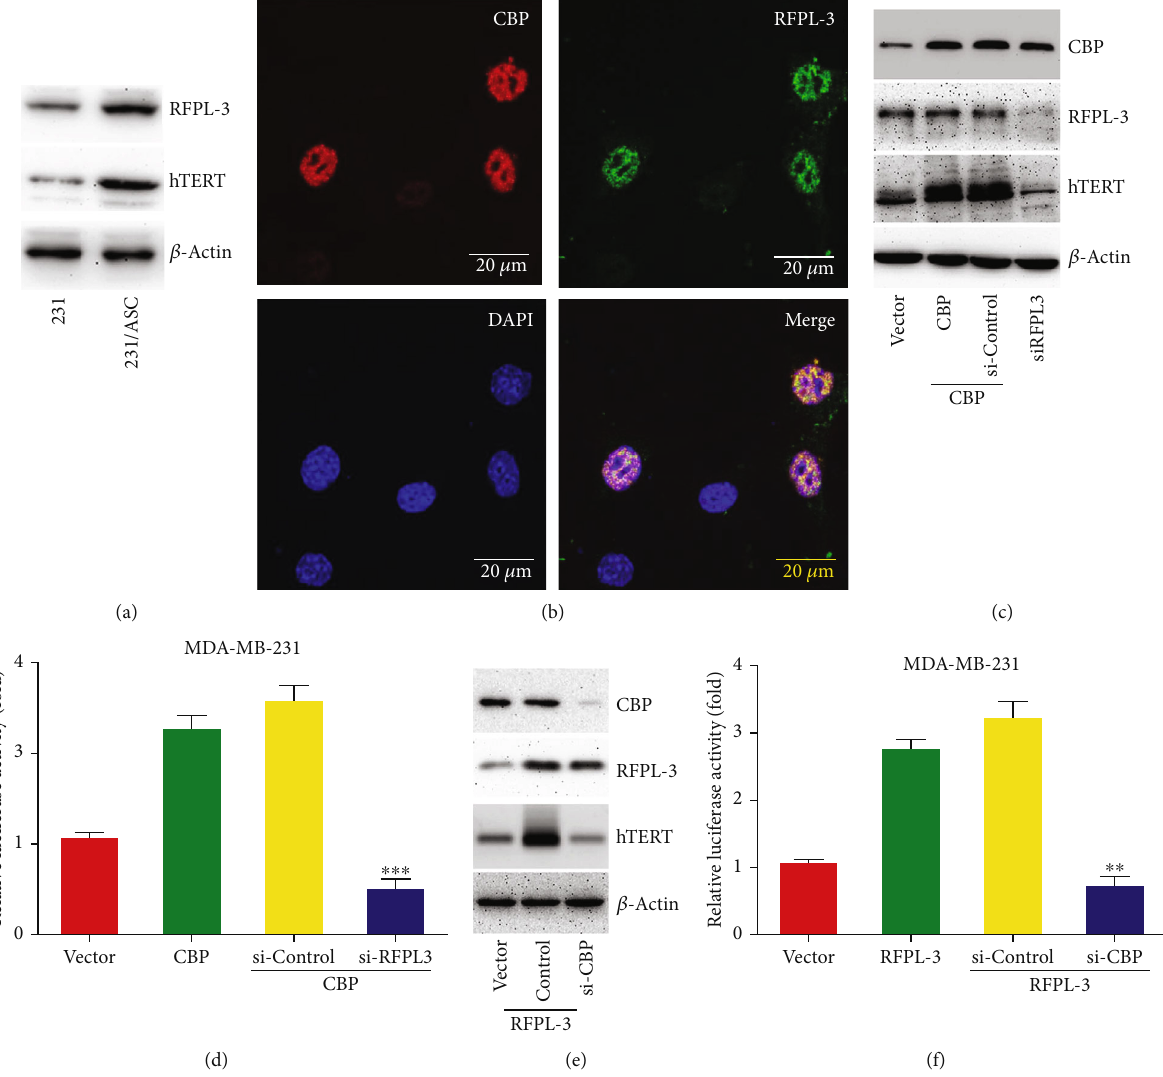
Figure 3: CBP coordinated with RFPL-3 to coregulate hTERT transcriptional activity in breast cancer cells. (a) MDA-MB-231 cells were treated with ASC culture supernatant, and then, the expression levels of RFPL-3 and hTERT protein were analyzed by western blot. (b) The localization of CBP and RFPL-3 in MDA-MB-231 cells was con fi rmed by confocal microscopy. (c) MDA-MB-231 cells were cotransfected with CBP vectors and nonspeci fi c siRNA or RFPL-3 siRNA, and then, the expression levels of CBP, RFPL-3, and hTERT were detected using western blot. (d) MDA-MB-231 cells with CBP upregulation were co-transfected with RFPL-3 siRNA or control siRNA and hTERT-luciferase plasmids, and the relative luciferase activity was examined. (e) MDA-MB-231 cells were co-transfected with RFPL-3 vectors and CBP-speci fi c siRNA or nonspeci fi c siRNA, and then, the expression levels of RFPL-3, CBP, and hTERT were evaluated by western blot. (f) CBP-speci fi c siRNA and hTERT promoter-driven luciferase plasmids were co-transfected into MDA-MB- 231 cells overexpressing RFPL-3, and then, the relative luciferase activity was analyzed in the cells. ∗∗ P < 0 : 01 , ∗∗∗ P < 0 : 001